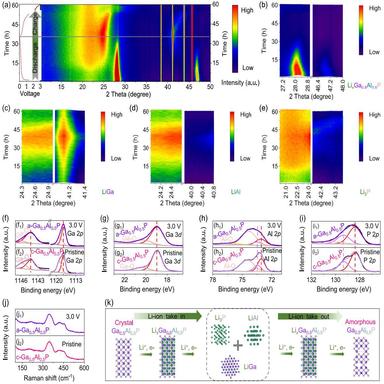
In-situ XRD characterization of the Ga0.5Al0.5P during the first cycle: (a) GCD curve along with the contour image; (b-e) In-situ XRD patterns of LixGa0.5Al0.5P, LiGa, LiAl and Li3P. (f-i) Ex-situ XPS characterization. (j) Ex-situ Raman characterization. (k) Schematic illustration of the Li-storage mechanisms.